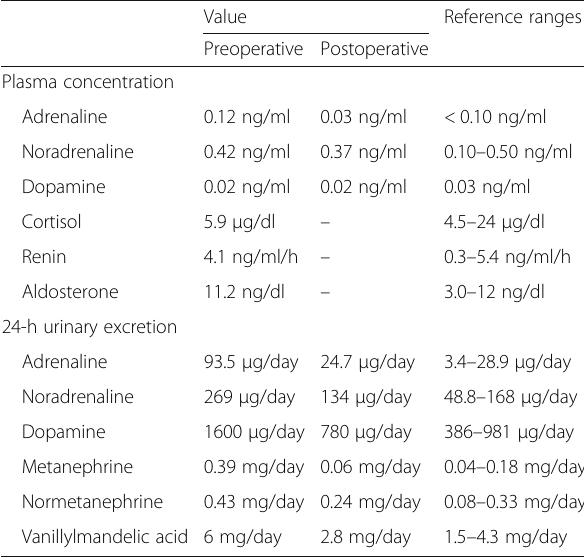
Table 1 Findings of catecholamines and their metabolites, and adrenocortical hormone Value Reference